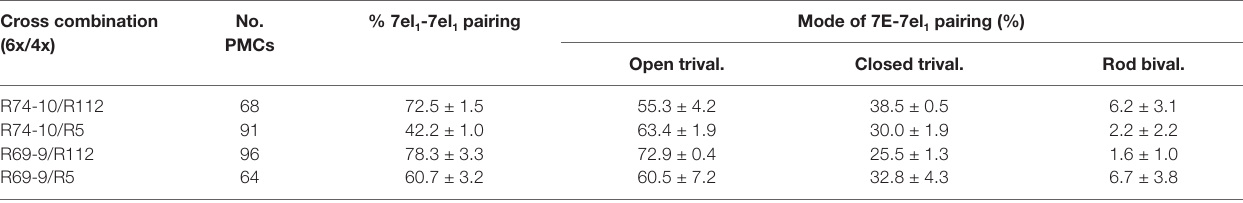
TABLE 2 | Meiotic metaphase I pairing behavior of 7D-7el 1 -7E and 7A-7el 1 chromosomes in pollen mother cells (PMCs) of pentaploid hybrids from crosses between 6x recombinants (R74-10 or R69-9) and 4x recombinants (R112 or R5). Cross combination